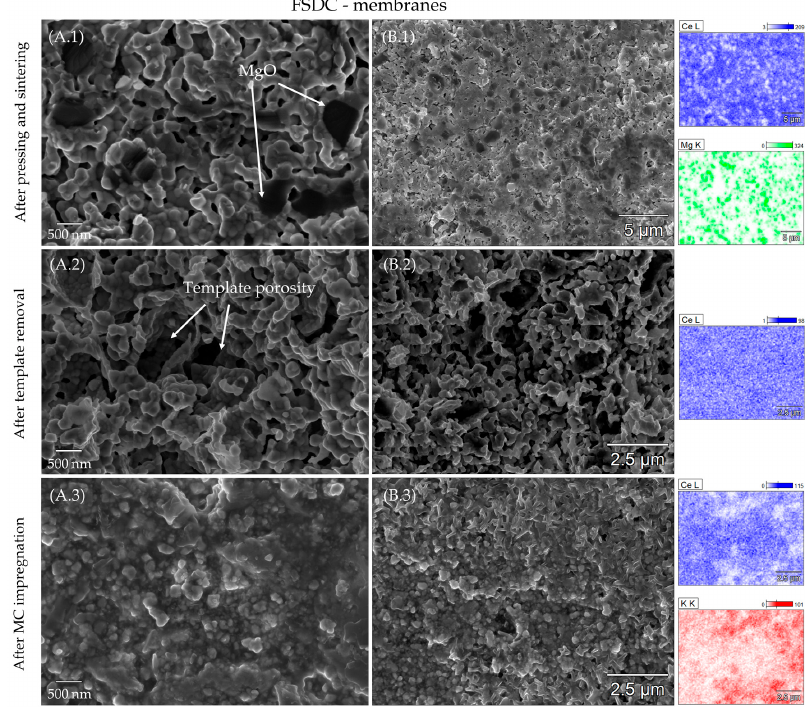
Figure 5. SEM images of a FSDC membrane all along its preparation steps: ( 1 ) after sintering, (2 ) after template removal and ( 3 ) after MC impregnation. ( A ) column displays SEM imaging, while ( B ) column displays EDX characterization with the correspondent mappings of Ce (blue), Mg (green) and K (red).